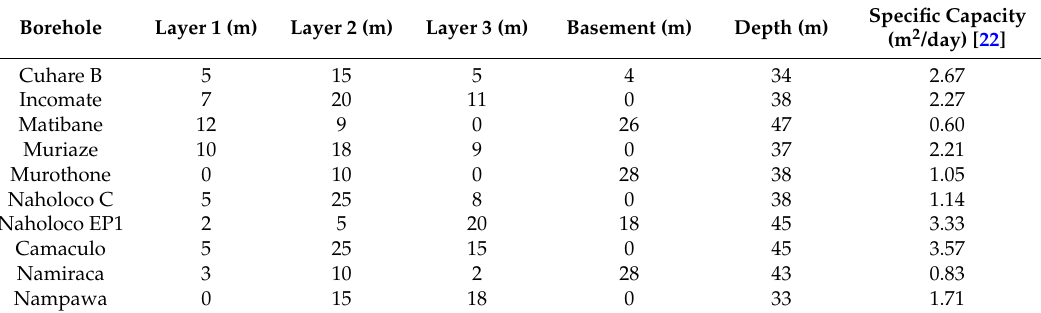
Table 2. Thickness of different ERT layers, drilled depth and specific capacity of the surveyed boreholes